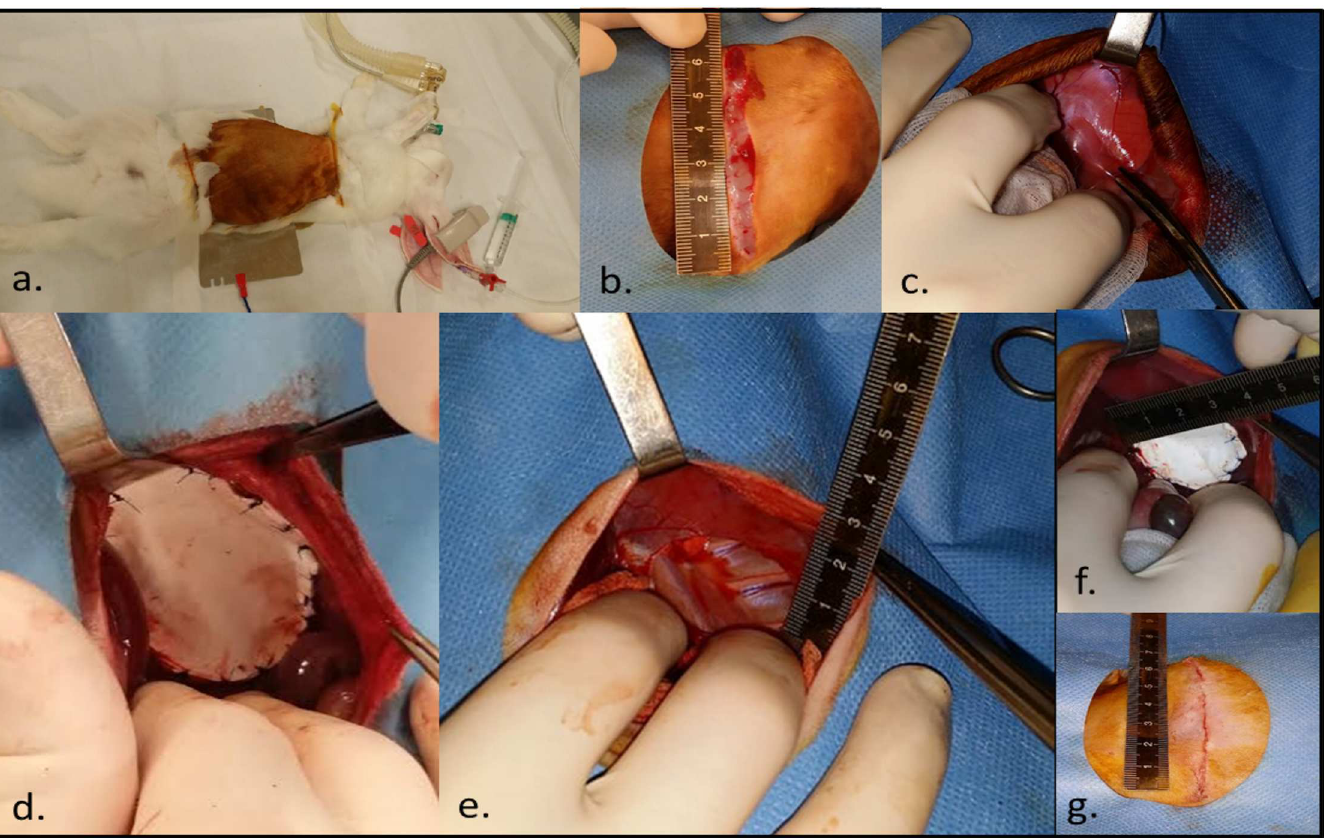
Fig 1. Creation and repair of a left diaphragmatic defect in a 6-week old rabbit. A. Operative position, B. Left subcostal transverse incision,C. Division of the posterior triangularligament of the liver, D. Subtotal left diaphragmatic excisionwith Gore-Tex mesh repair, E. 3 * 3cmdiaphragmaticdefect, F. Repair with a 3,5 * 3,5cmGore-Tex patch G. Sub-cuticular skin